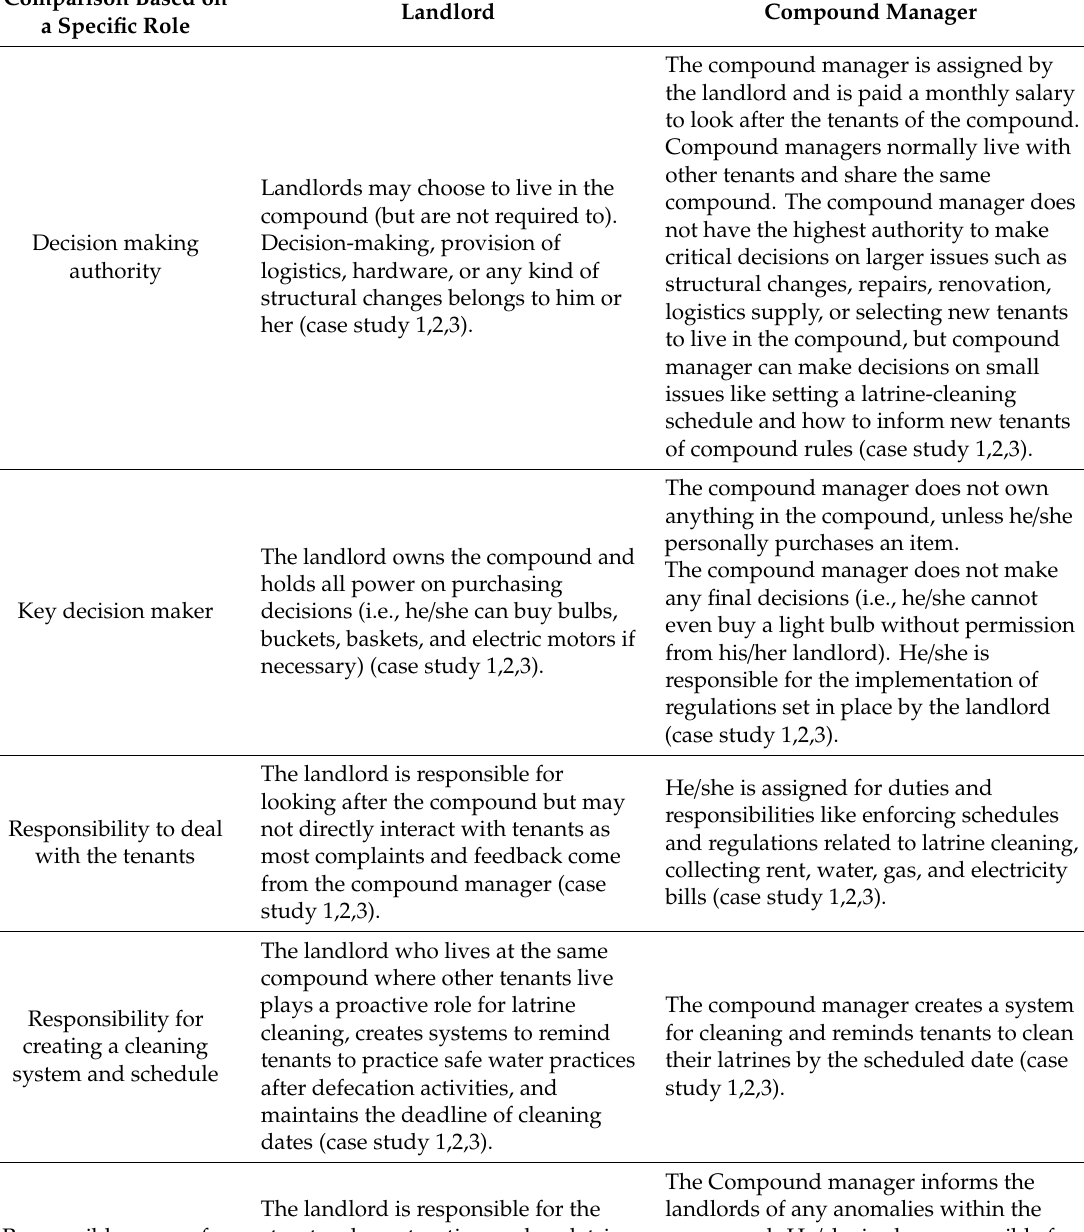
Table 3. Comparison between the role of the landlord and compound manager after implementation of the latrine cleanliness intervention in three slum communities in Dhaka: Mohakhali, Mohammadpur, Mirpur. Comparison Based